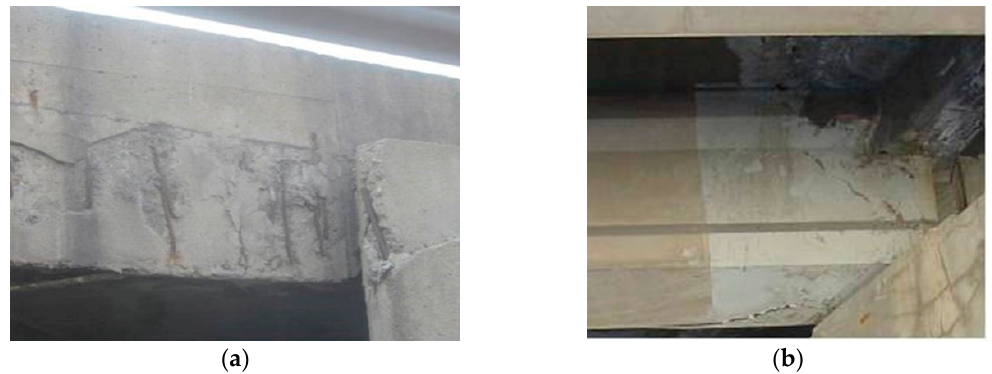
Figure 1. End region condition of precast concrete (PC) bridge girders: ( a ) end region damage and ( b ) mortar repair of girder end.